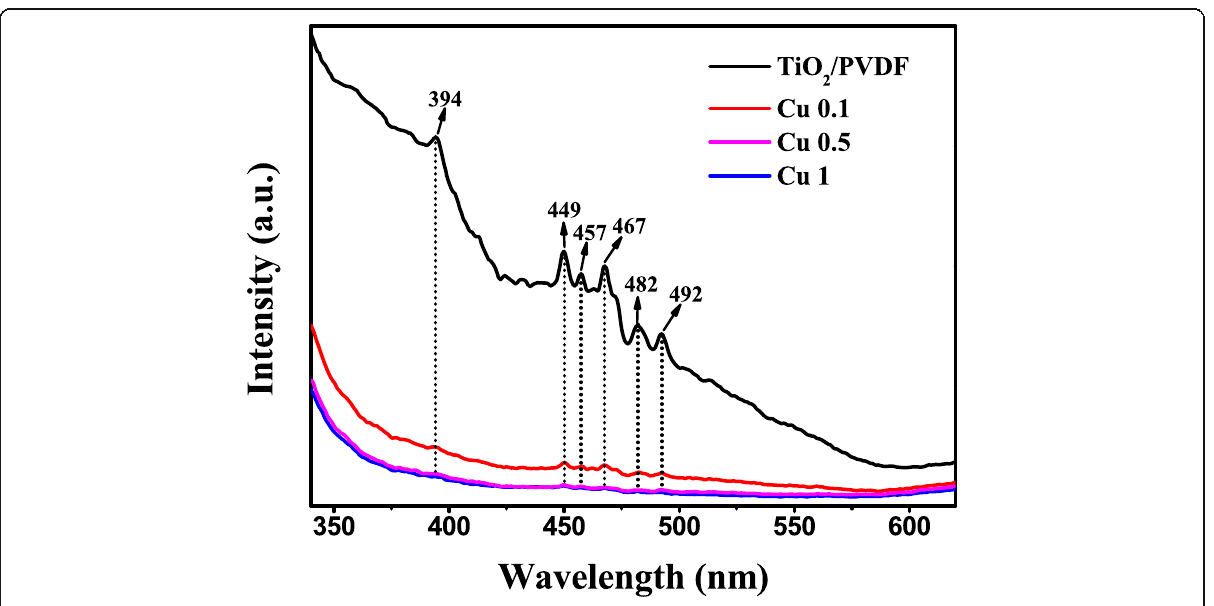
Fig. 6 PL spectra of TiO 2 /PVDF, Cu 0.1, Cu 0.5, and Cu